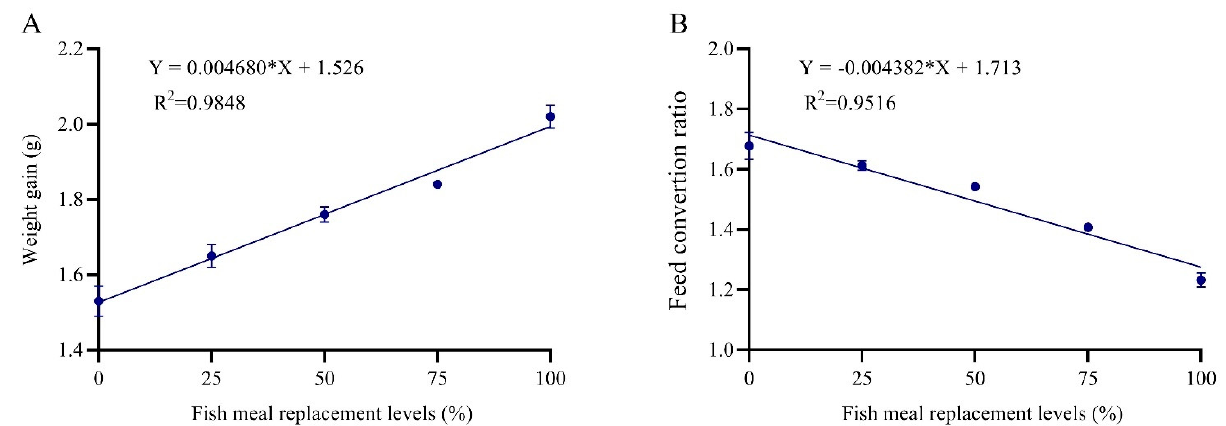
Figure 1. The linear regression between weight gain ( A ) and feed conversion ratio ( B ), and the percentage of dietary fishmeal replacement level for grey mullet, Mugil cephalus , fed five experimental diets for 60 days.